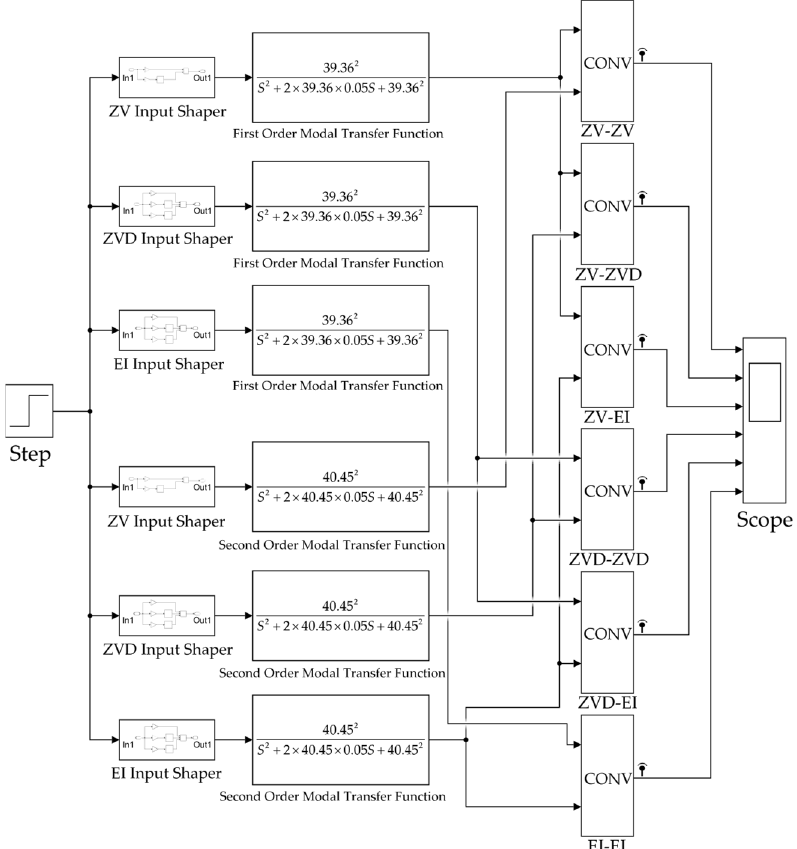
Figure 13. Block diagram construction of dual-modal input shapers.